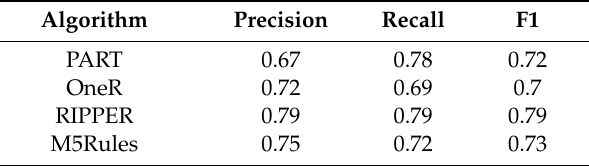
Table 3. Validation results among algorithms applied.